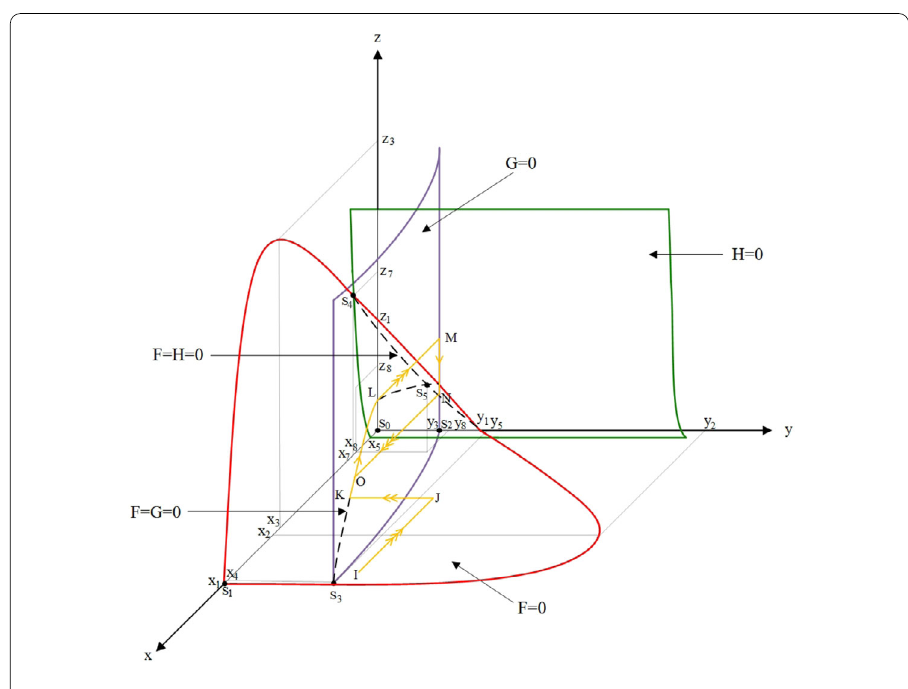
Figure 1 Shapes and relative positions of the manifolds where the parametric values of system of Eqs. (4)–(6) satisfy the conditions in Theorem 1